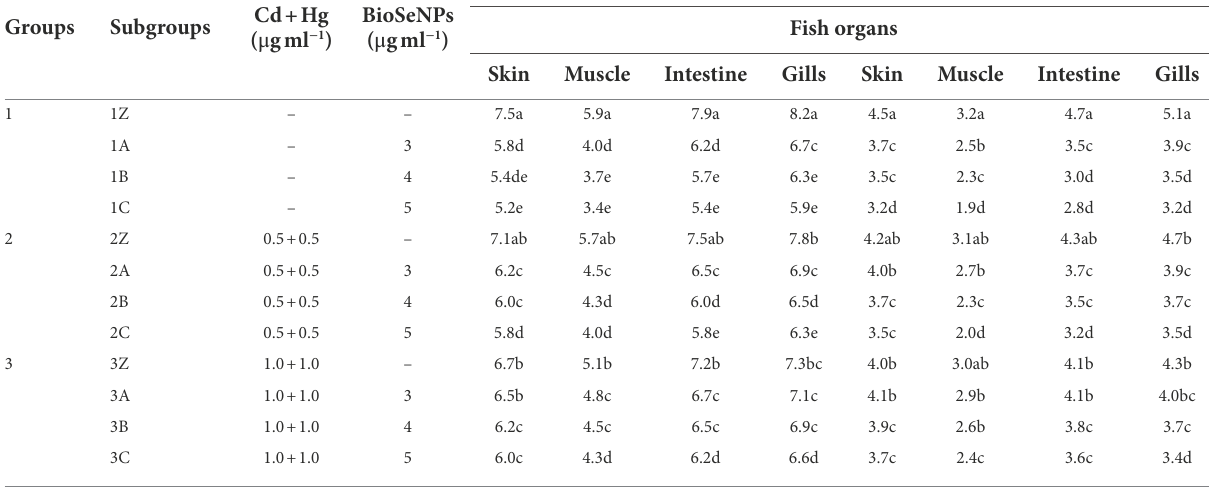
TABLE 7 Total bacterial and Aeromonas counts in Nile talipa ( Oreochromis niloticus ) fish organs (skin, muscle, intestine and gills) after 10 weeks of treatment.